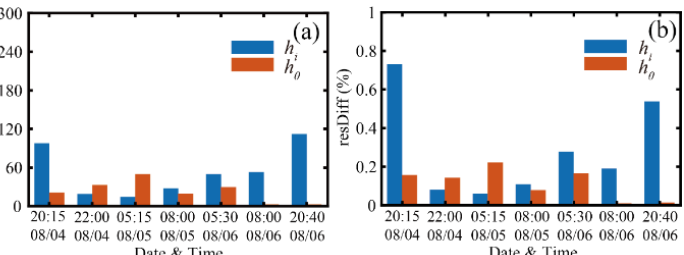
Figure 11. ( a ) Absolute differences (absDiff) and ( b ) relative differences (reDiff) obtained at each time point shown in Figures 9 and S5. The blue histograms indicate the relative differences between ℎ 𝑖 and ℎ , and the red histograms indicate the relative differences between ℎ 𝜃 and ℎ .